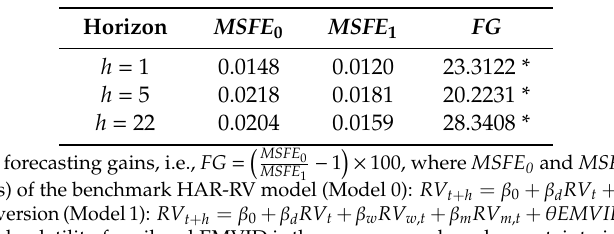
Table 3. Out-of-Sample Forecasting